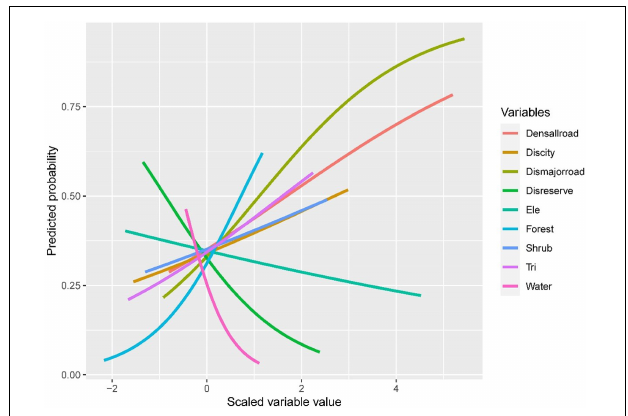
FIGURE 3 | The response curve of distribution in Jilin to the Asiatic Black